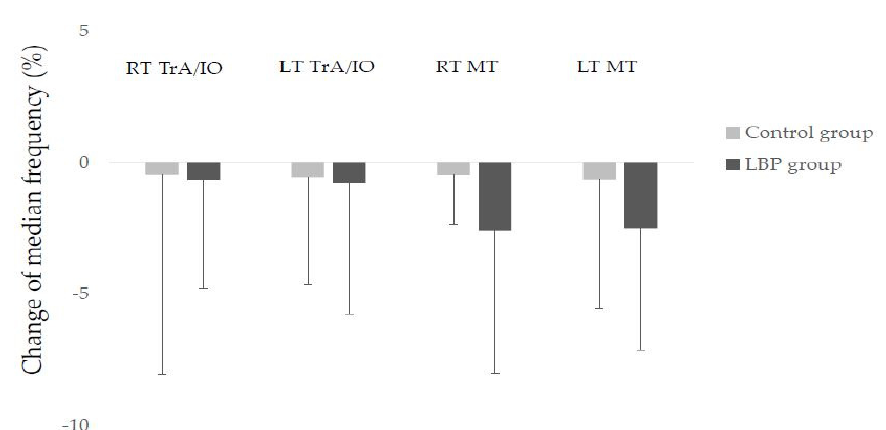
Figure 1. Mean change of median frequency in trunk muscles after prolonged sitting with slumped posture. EMG median frequency was normalized to the initial value.